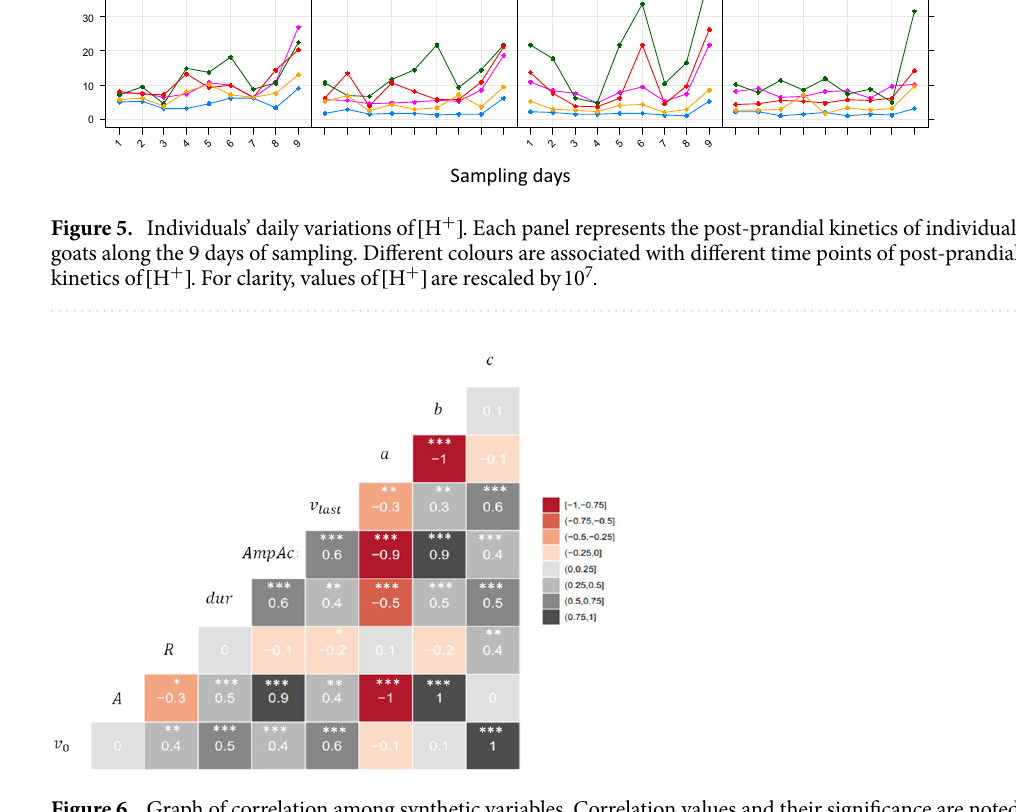
Figure 6. Graph of correlation among synthetic variables. Correlation values and their significance are noted. Symbols *, ** and *** mean p values smaller than 0.05, 0.01, and 0.001, respectively. Because the distribution of synthetic variables was not Gaussian, the Spearman correlation test was used. a , b and c are the coefficients of the original quadratic function. A , v 0 and R are parameters of the new re-parametrised function. AmpAc and dur are parameters calculated after fitting the model to individual [ H + ] daily